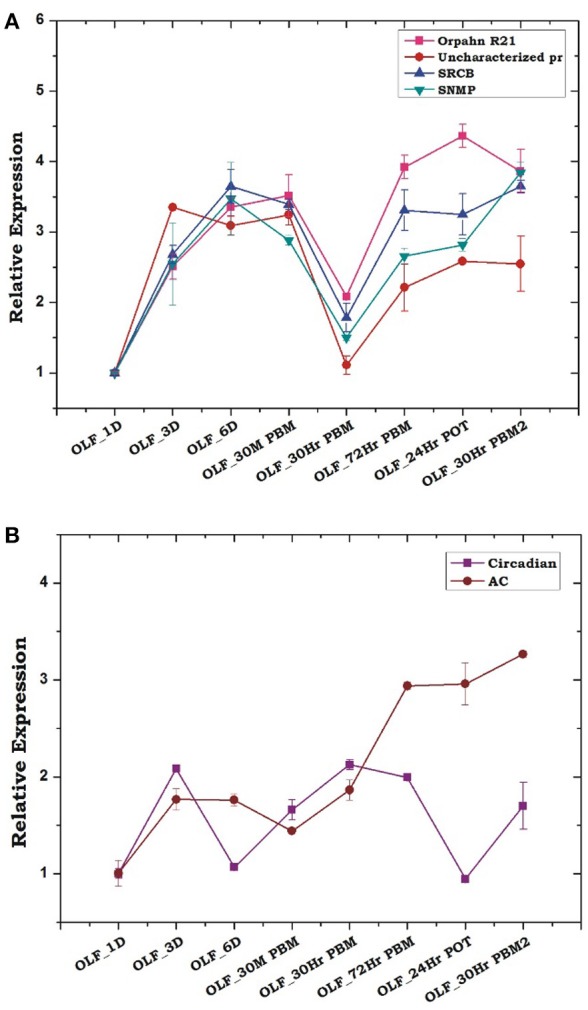
Transcriptional responses of other olfactory genes hypothesized to play a crucial role in host-seeking and blood-feeding behavior. (A) Relative expression profiling of other receptor genes according to blood meal time series (described in Figure 5). Orphan R21: Orphan receptor 21; Uncharacterized Pr, Uncharacterized protein; SRCB, Scavenger Receptor class B; SNMP, Sensory neuron membrane protein. (B) Transcriptional profiling of other signaling molecule in response to blood meal time series experiment. Circadian, Circadian gene; AC, Adenylyl Cyclase. The significance of suppression of other olfactory genes expression after 30 h of post blood meal are as follows: Orphan R21 ≤ 0.002; Uncharacterized pr ≤ 0.002; SRCB ≤ 0.006; SNMP ≤ 0.007.